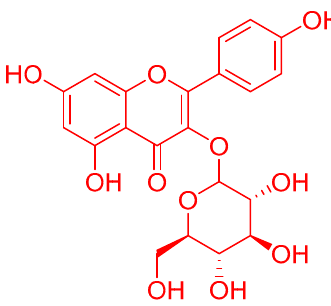
Figure 10. The structure of astragalin.